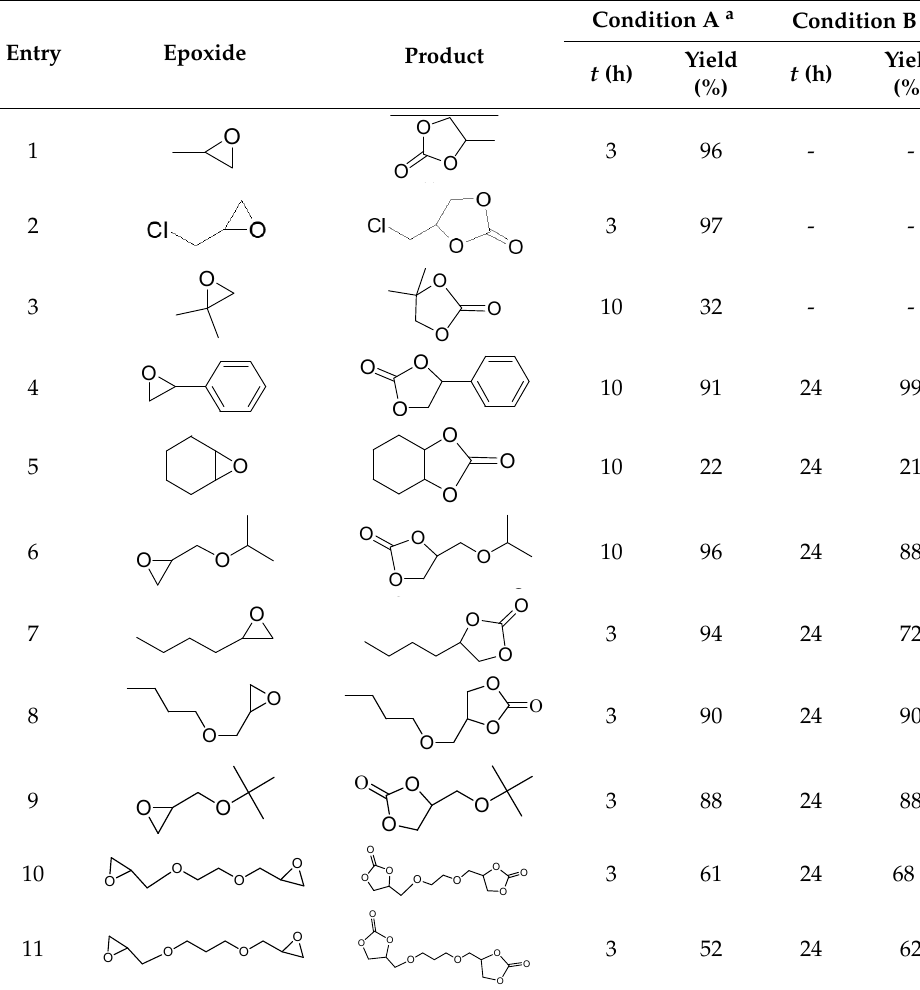
Condition A a Condition B